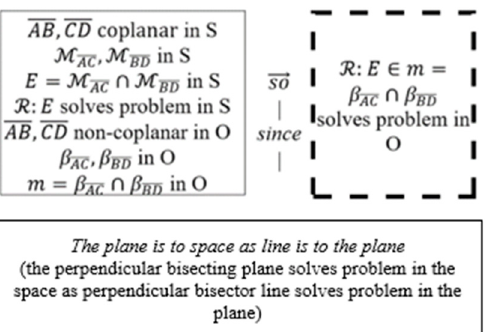
Figure 7. Analogical argument to solve the problem in 3D domain. (S indicates 2D geometry –known domain–; O indicates 3D geometry –unknown domain–. (cid:2010) (cid:3025)(cid:3026)(cid:3364)(cid:3364)(cid:3364)(cid:3364) indicates perpendicular bisecting domain–; O indicates 3D geometry –unknown domain–. β plane to (cid:1850)(cid:1851)(cid:3364)(cid:3364)(cid:3364)(cid:3364) ). to XY ).